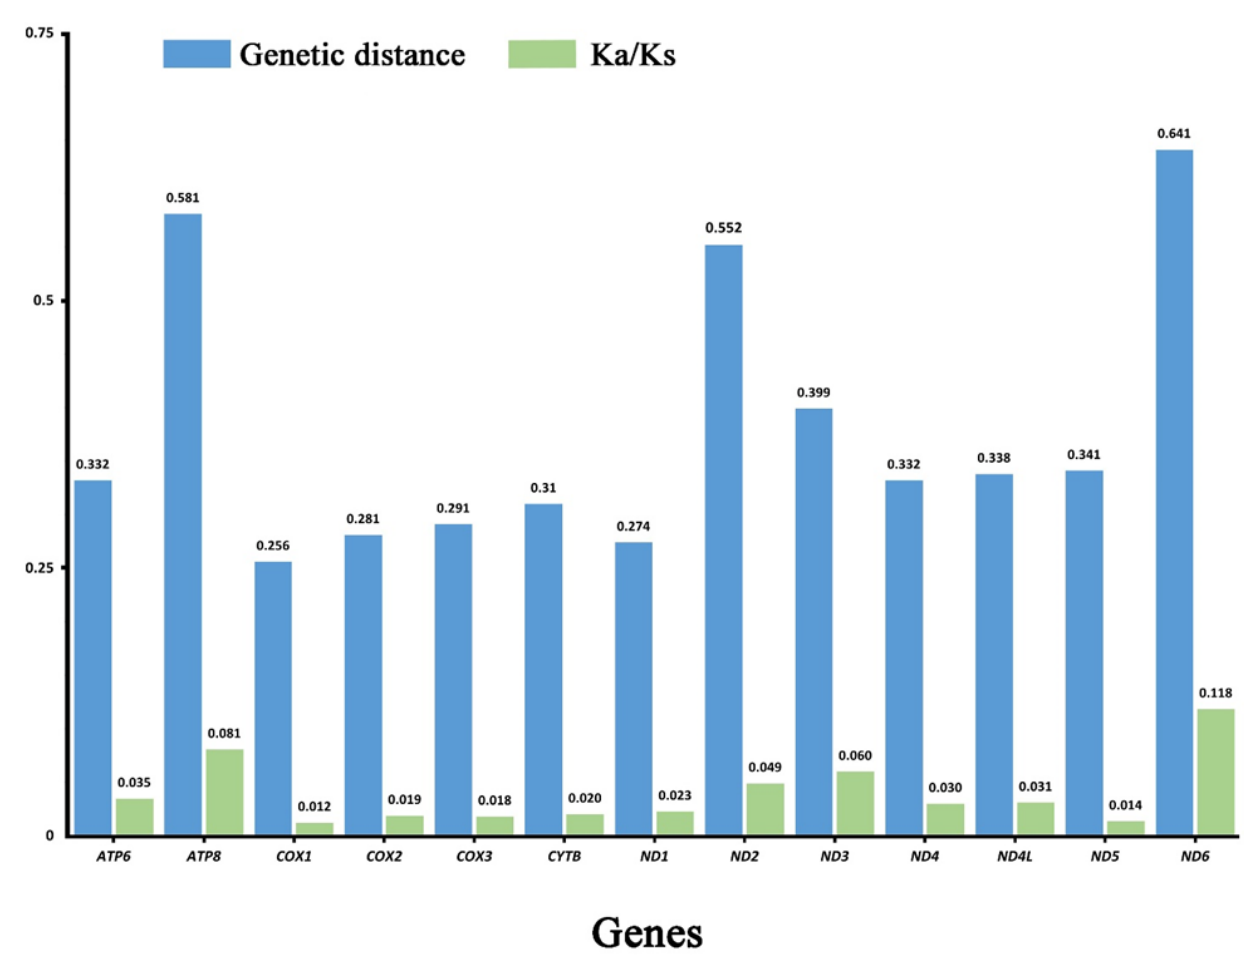
Figure 3. Genetic distance (on average) and non-synonymous (Ka) to synonymous (Ks) substitution rates of 13 PCGs among these 4 species.